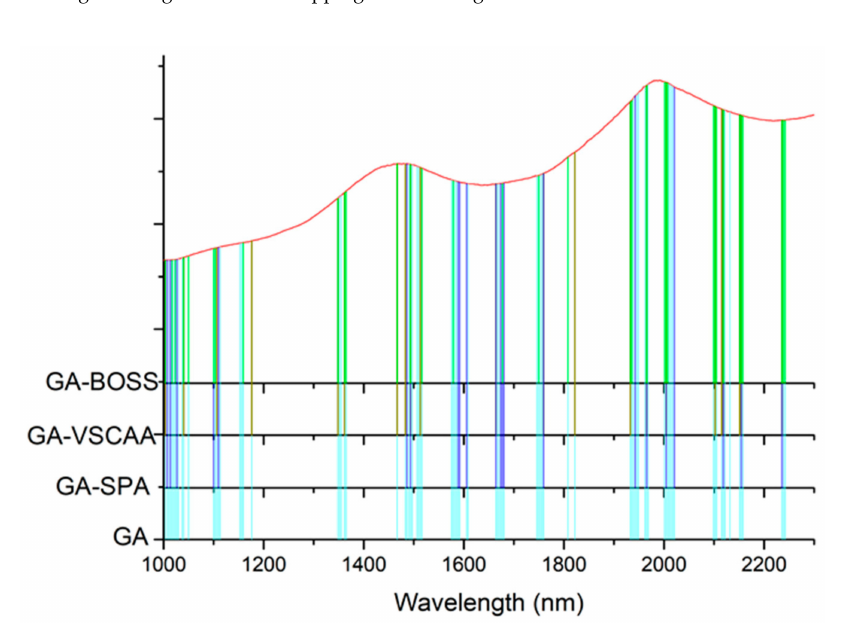
Figure 10. The useful variables selected by GA, GA-SPA, GA-VSCAA, and GA-BOSS. GA-BOSS: genetic algorithm-bootstrapping soft shrinkage; GA-VSCAA: genetic algorithm-variable stability and cluster analysis algorithm; GA-SPA: genetic algorithm-successive projections algorithm; GA: genetic